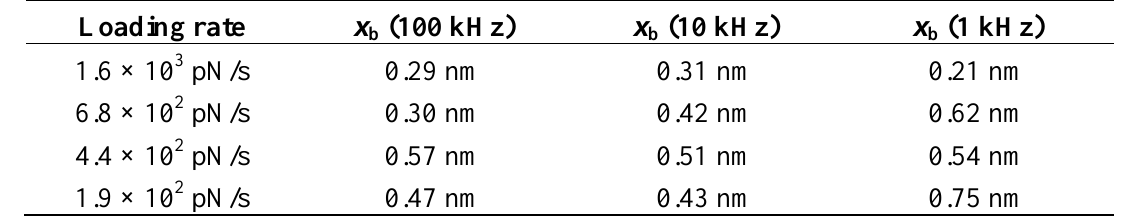
Table 1. Potential barrier position estimated from the distribution width, i.e. , analysis of the shape of the rupture force distribution for each sampling